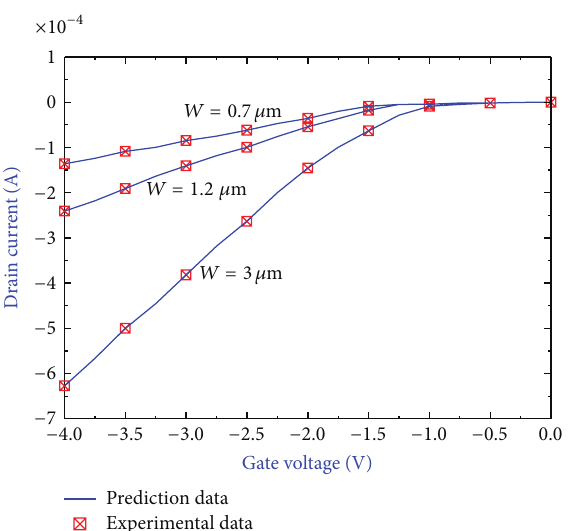
Figure 15: Comparison of 𝐼 𝑑 measured results and prediction data of the group 2B diagnostic samples (as 𝑊 = 0.7 , 1.2, 3- 𝜇 m, 𝑉 𝑑 = −3